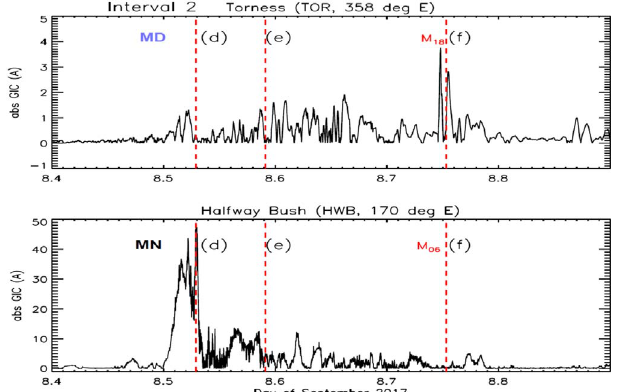
September 2017. The times of magnetic local dawn (M 06 ) and dusk (M 18 ) are indicated, in addition to midday (MD) and